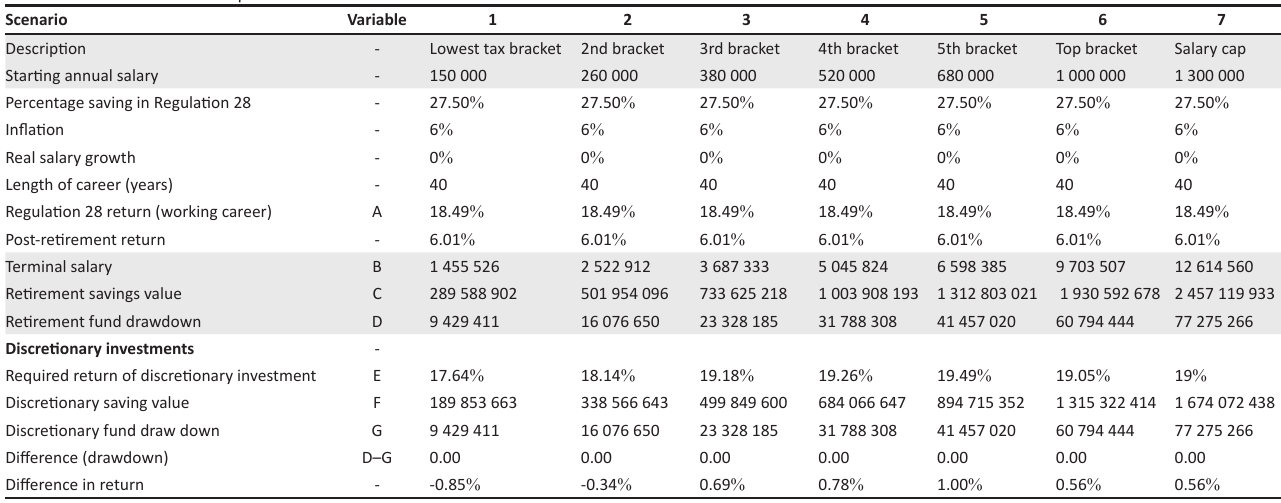
TABLE 1: Differential return